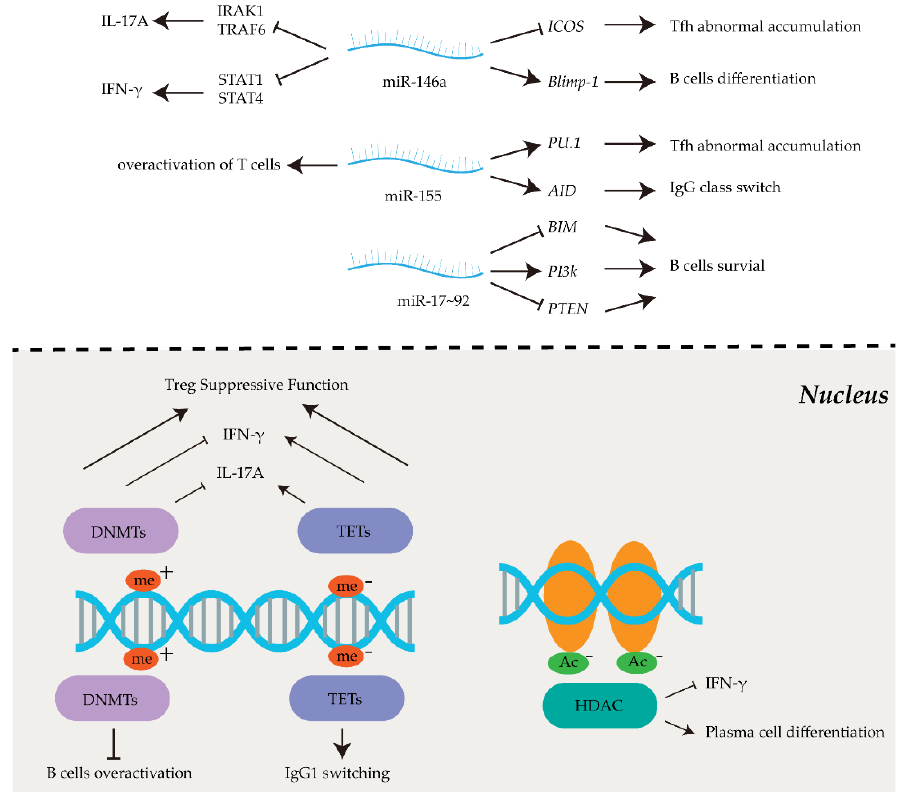
Figure 1. Epigenetic regulations in immune responses. Epigenetic modifications, such as DNA methylation ( bottom left ), histone modification ( bottom right ) and non − coding RNA expression ( top ), play critical roles in immune response. Abnormal epigenetic changes could lead to the dysregulation of immune responses.